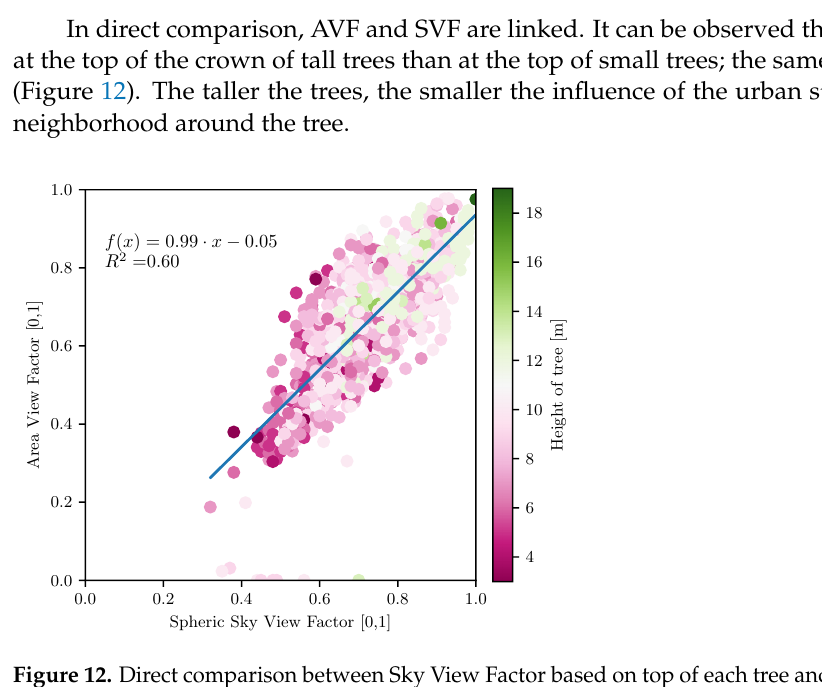
Figure 11. Differences between Sky View Factor based on top of each tree crown and virtually remote sensed Area View Factor in the urban district Rieselfeld in Freiburg, Germany. Trees are depicted in SVF and AVF < SVF , respectively. green and purple for AVF ≥